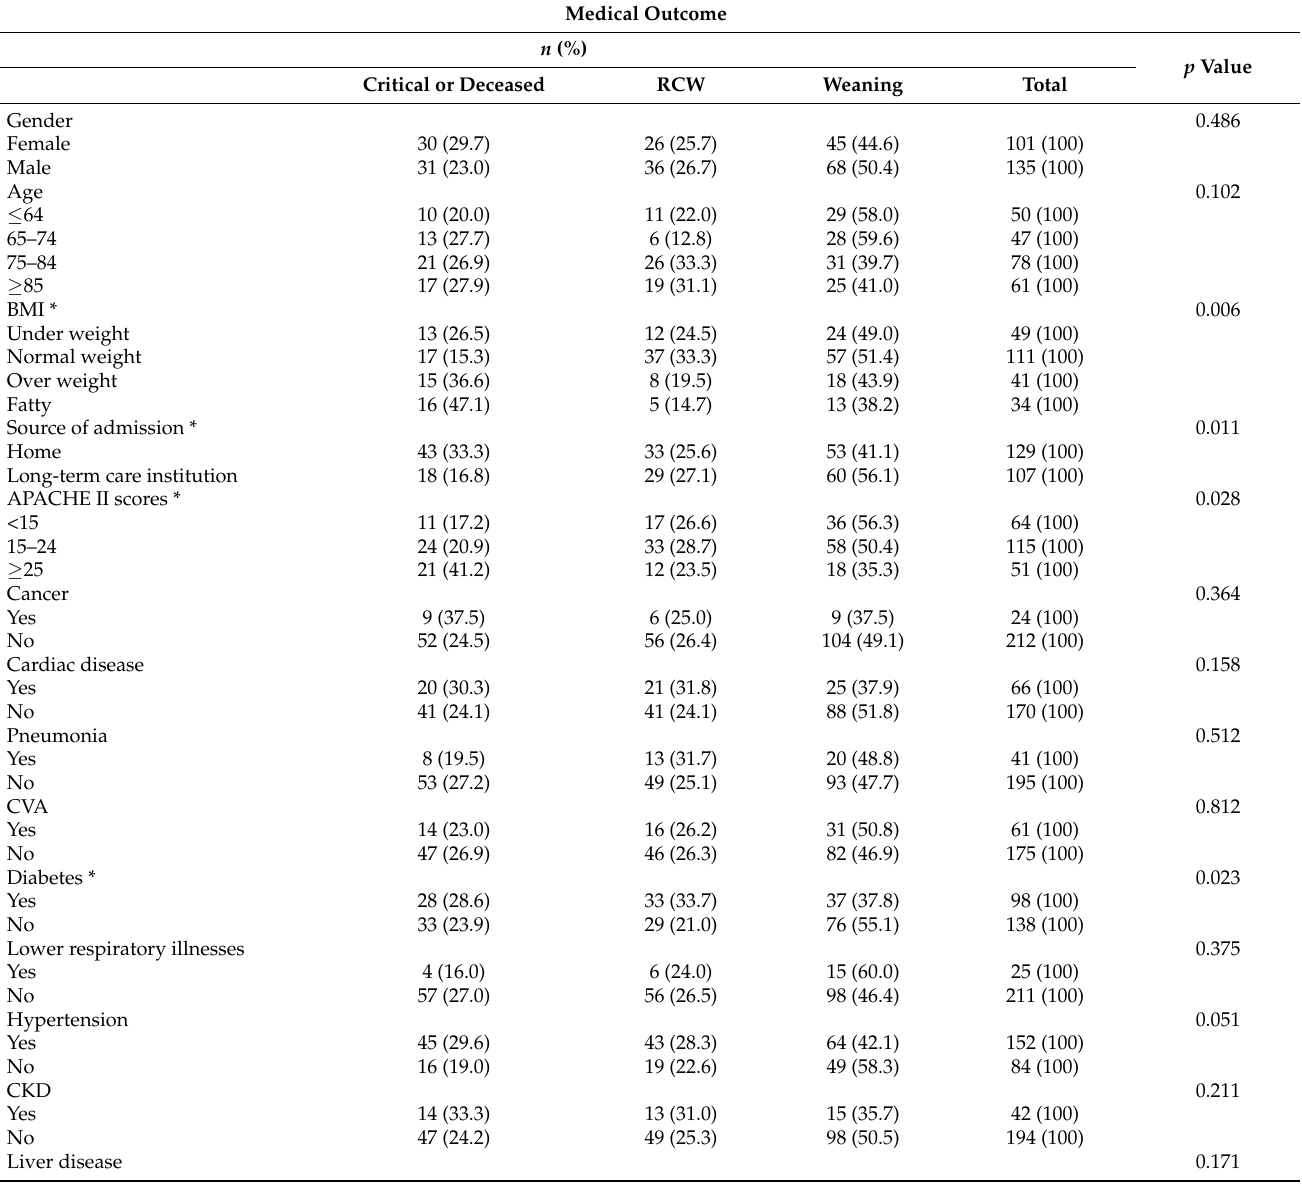
Table 2. The distribution of medical results s according to different